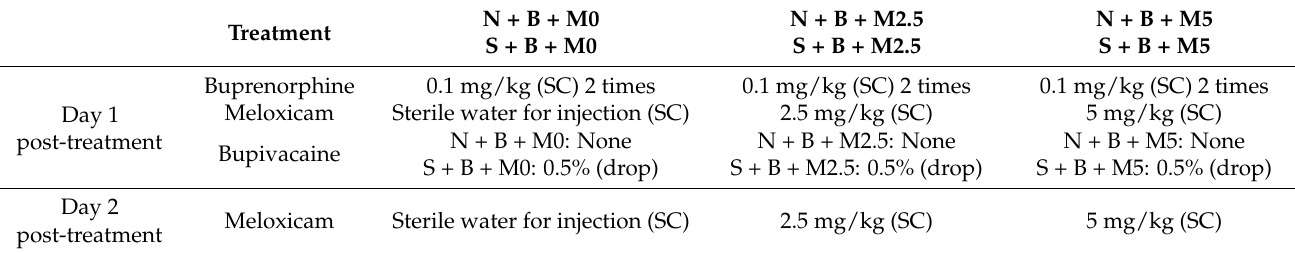
Table 1. Drugs administered to each group of mice. Abbreviations in the table; N: nonsurgical group; S: surgical group. B: 0.1 mg/kg buprenorphine administration. M0: 0 mg/kg